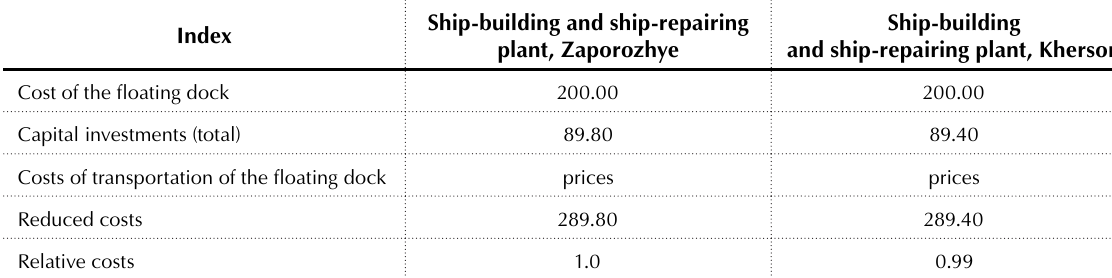
Table 6. The reduced costs on acquisition of the floating docks “Pallada”, mln.